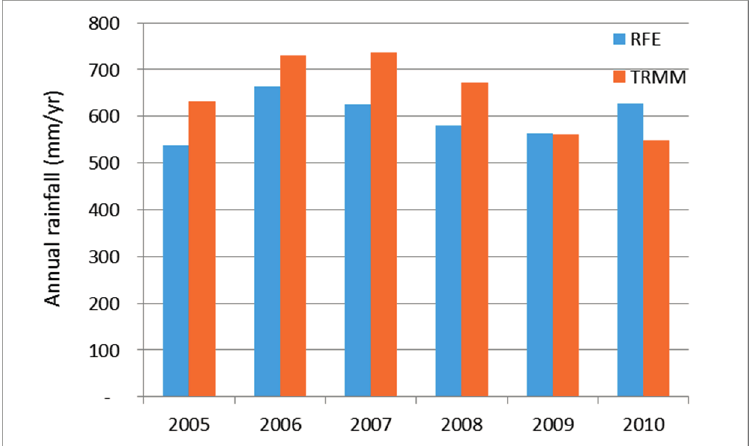
Figure 2. Annual rainfall of the Nile as estimated by the Tropical Rainfall Measurement Mission (TRMM) and RainFall Estimates (RFE) open-access rainfall